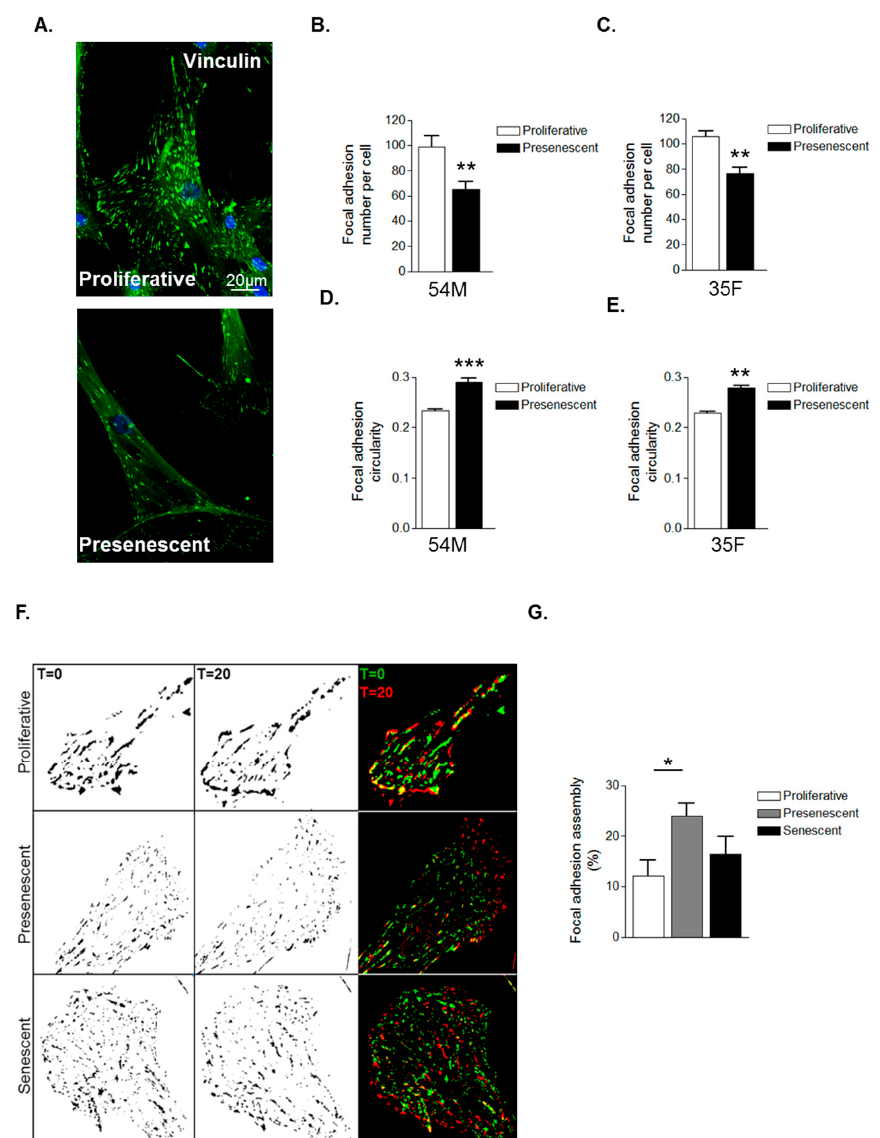
Figure 3. VSMC ageing influences focal adhesion organisation. ( A ) Representative confocal images of proliferative and presenescent VSMCs stained for vinculin (green) and DAPI (blue); Scale bar represents 20 μ m. Graphs show ( B , C ) focal adhesion (FA) number per cell and ( D , E ) FA circularity of 54M and 35F VSMC isolates respectively. Data represent combined data analysing 500–1000 focal adhesions from >100 cells from three independent experiments (** p ≤ 0.01 and *** p ≤ 0.0001); ( F ) Representative IRM overlay images of proliferative, presenescent and senescent 35F VSMCs at t = 0 min (green) and t = 20 min (red); ( G ) Graph shows focal adhesion assembly over a 20-min period and represents the combined data of 15–20 cells per group pooled from three independent experiments (* p ≤ 0.05).